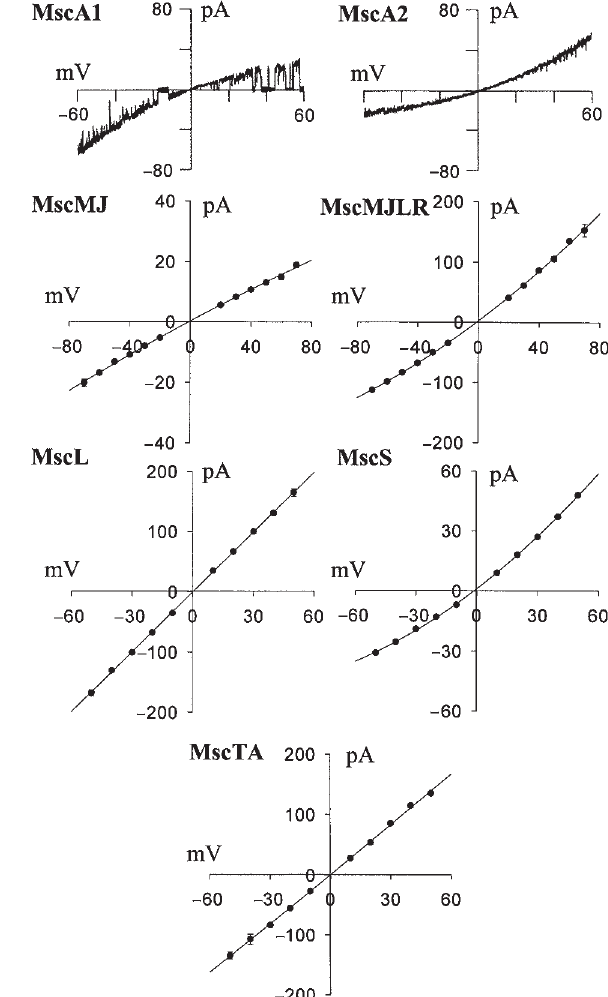
Figure 3. Comparison of conductive properties of bacterial and archaeal MS channels. From top to bottom: MscA1 and MscA2 of Haloferax volcanii (adapted from Le Dain et al. 1998); MscMJ and MscMJLR of Methanococcus jannaschii (adapted from Kloda and Martinac 2001 b ); MscL and MscS of Escherichia coli ; and MscTA of Thermoplasma acidophilum (adapted from Kloda and Martinac 2001 c ). Current–voltage plots were obtained in a symmetric record- ing solution of 200 mM KCl, 5 mM MgCl 2 , 5 mM HEPES, pH 7.2, from data where the voltage was stepped to the given potential, except for the MscA1 and MscA2 single-channel currents, which were ob- tained for a voltage ramp from –60 to +60 mV over 2.6 and 1.7 s, re-